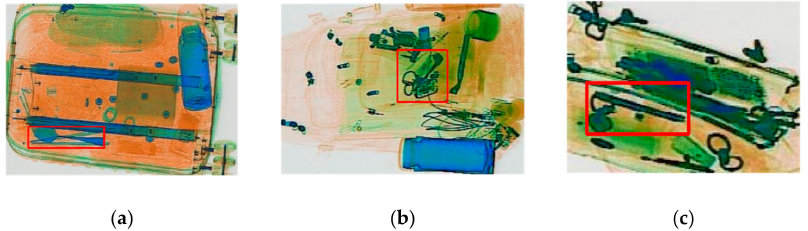
Figure 10. Exemplar images of suppressed detections. Wrong detections for ( a ) knife, ( b ) scissors, and ( c ) another pair of